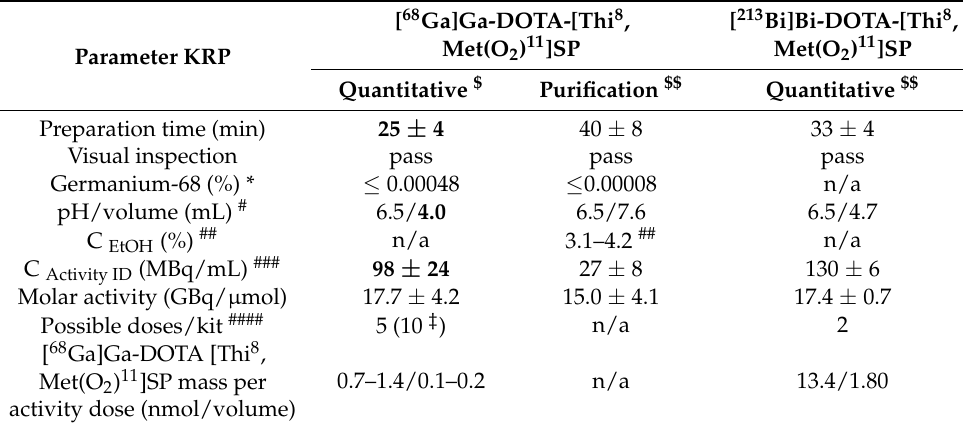
Table 6. Evaluation of quantitative and SPE-purified preparations of [ 68 Ga]Ga-/[ 213 Bi]Bi-DOTA- [Thi 8 , Met(O 2 ) 11